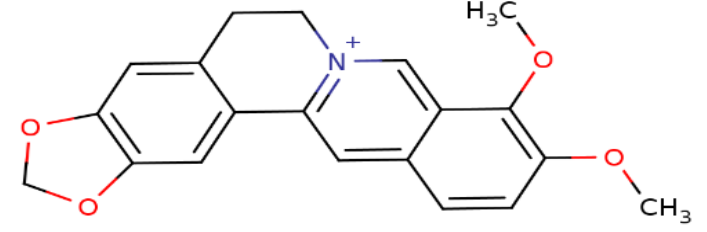
Figure 1. Chemical structure of berberine.